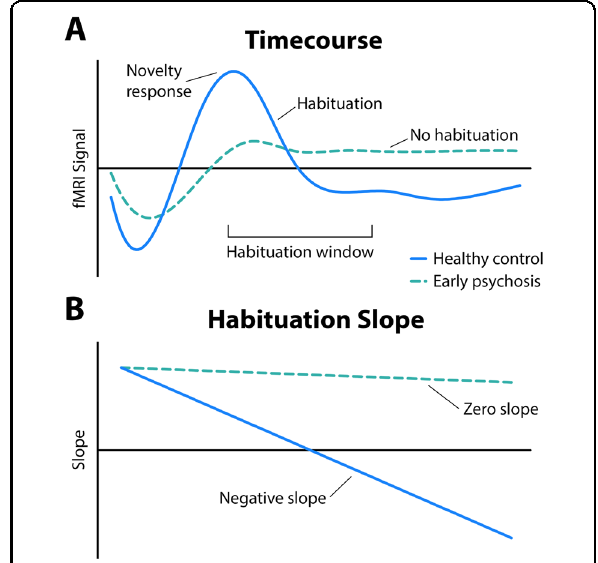
Fig. 1 We studied habituation of neural response over time. Functional magnetic resonance imaging (fMRI) signal was extracted for a 10 s window beginning with the novelty response ( A ) and habituation slopes were calculated ( B ). Habituation was characterized as the change in fMRI signal over time with more negative slopes indicating greater